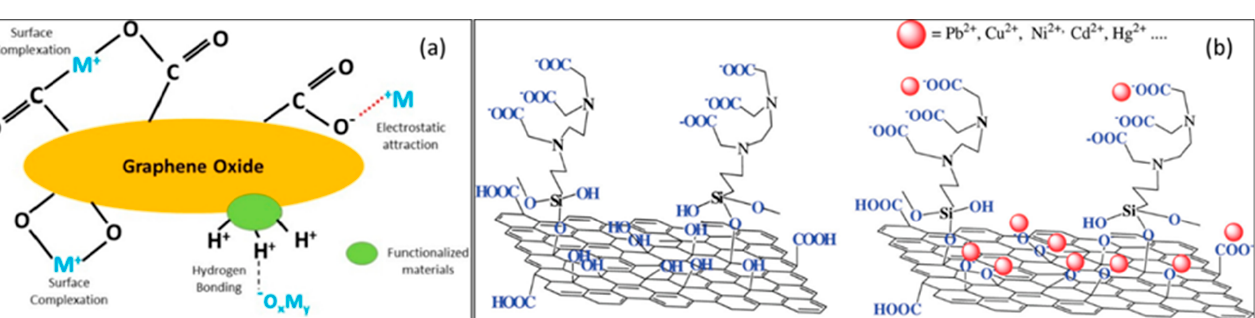
Figure 13. ( a ) Probable toxic heavy metal removal mechanism on graphene oxide as an adsorbent from water. Reprinted with permission from [183]. 2020, Chemosphere. ( b ) Scheme shows the chemical structure of ethylenediaminetetraacetic-acid-functionalized graphene oxide before (left) and after it has been exposed to heavy metal cations (right) Reprinted with permission from [130]. 2012, ACS Appl. Mater. Interfaces.